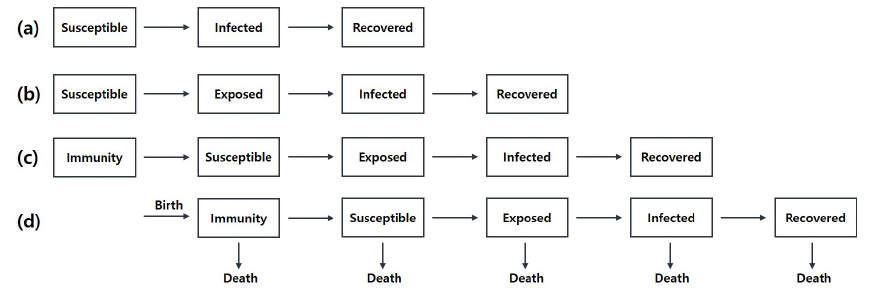
Figure 1. Examples of SIR model: ( a ) basic model; ( b ) SEIR model; ( c ) MSEIR model; ( d ) add life cycle parameter (death, birth), MSEIR